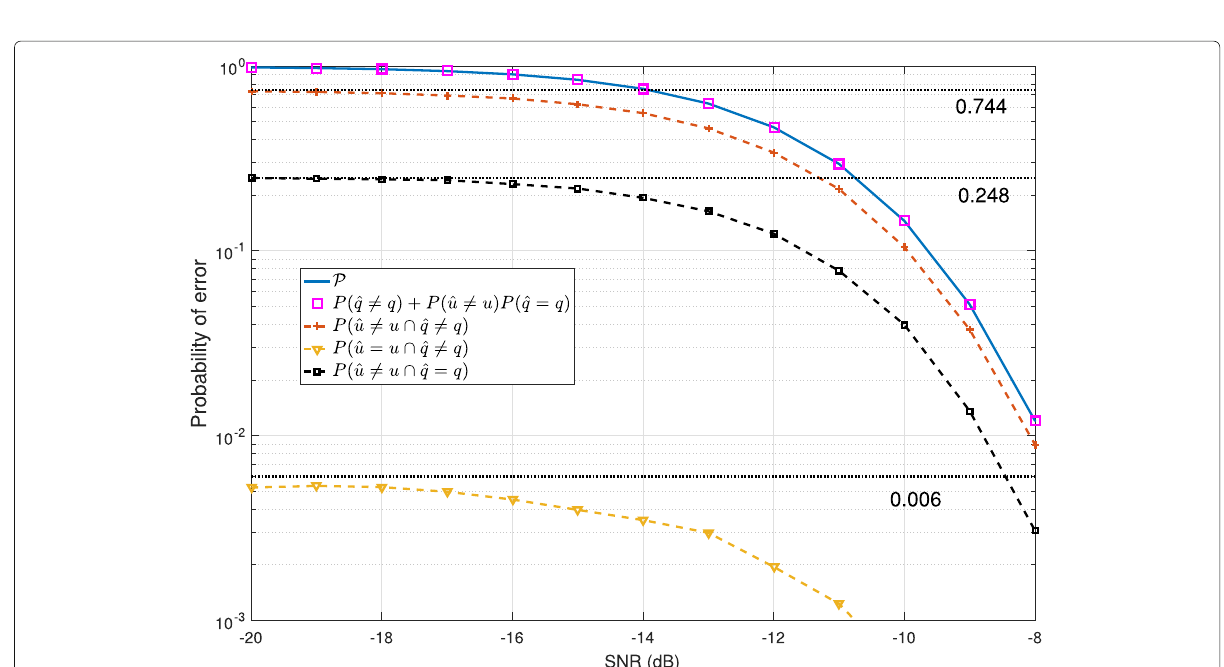
Fig. 4 Probabilities of error versus SNR (dB), P and developments from (21), (22), and